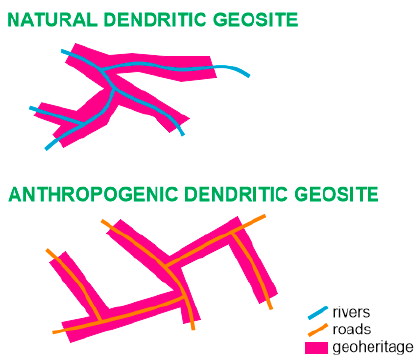
Figure 7. Dendritic geosites of different origin.